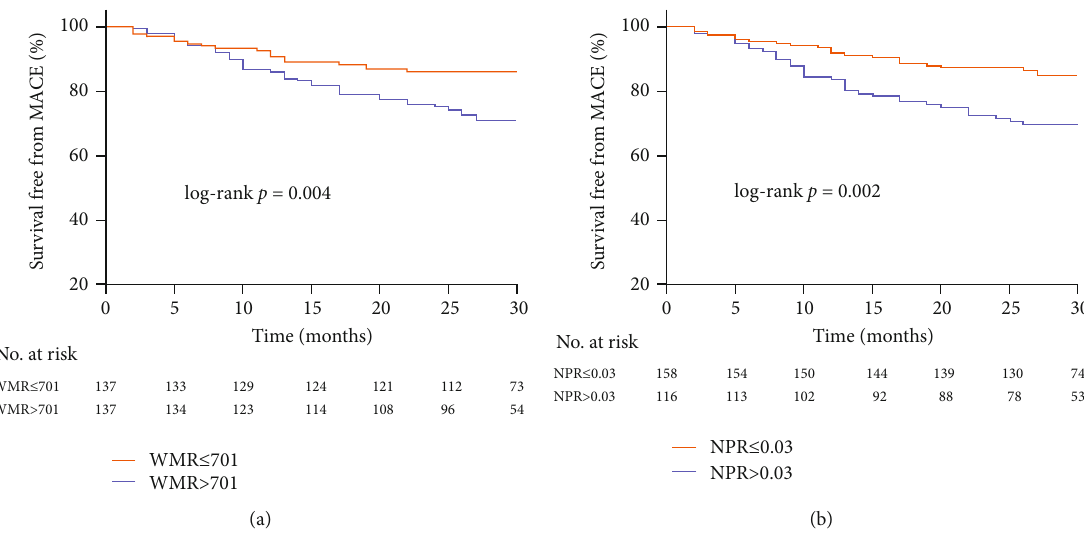
Figure 4: Kaplan-Meier survival curves for MACE in MINOCA patients with WMR (a) and NPR (b) median. WMR: white blood cell count to mean platelet volume ratio; NPR: neutrophil-to-platelet ratio; MACE: major adverse cardiovascular